Question: Provide a publication-style caption for this figure.
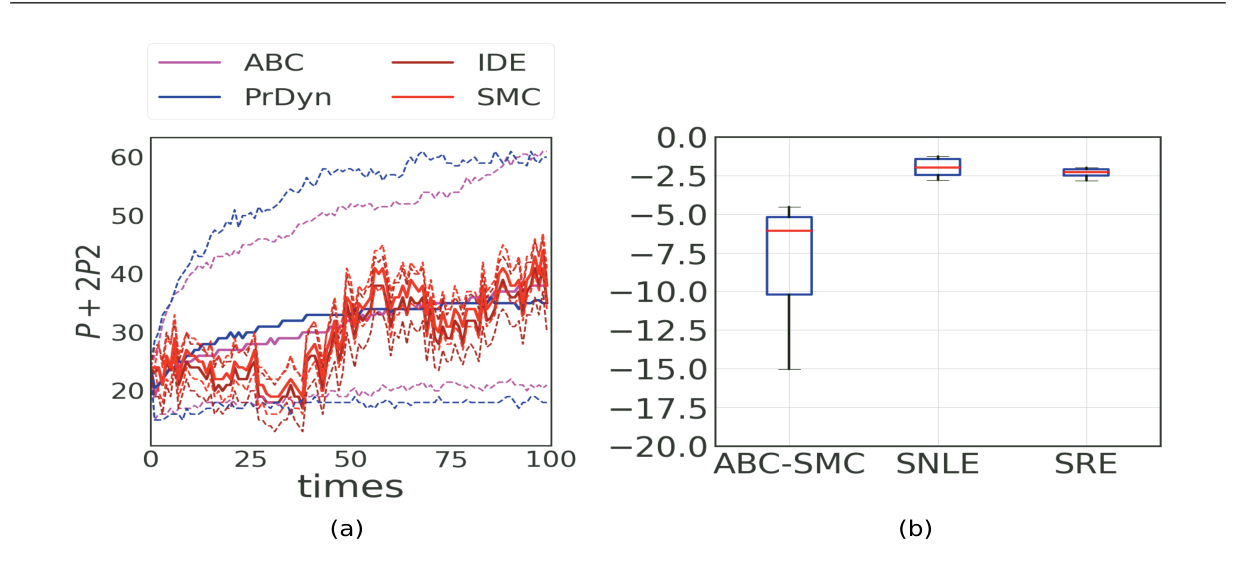
Answer: Accuracy of parameter estimates for the Lotka-Volterra (a) and Prokaryotic autoregulator (b) models, assessed using the log probability of the true generative parameter vector, summarised across the 10 datasets. The log probabilities were obtained by fitting a mixture of multivariate Gaussian densities to 500 samples drawn from an estimate of p(θ|y) obtained using each method.